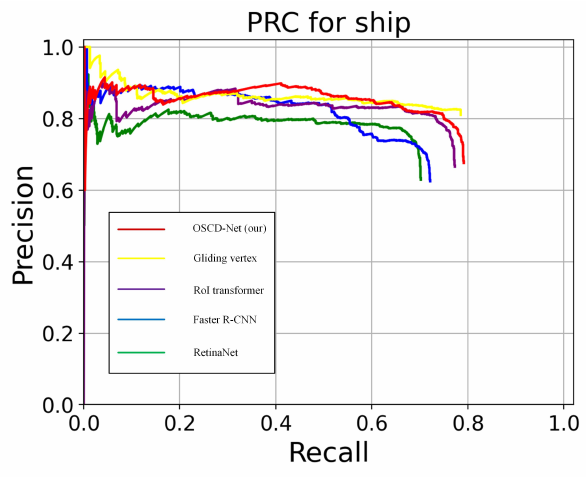
Figure 14. Precision–recall curve of different methods on the DOTA-Ship